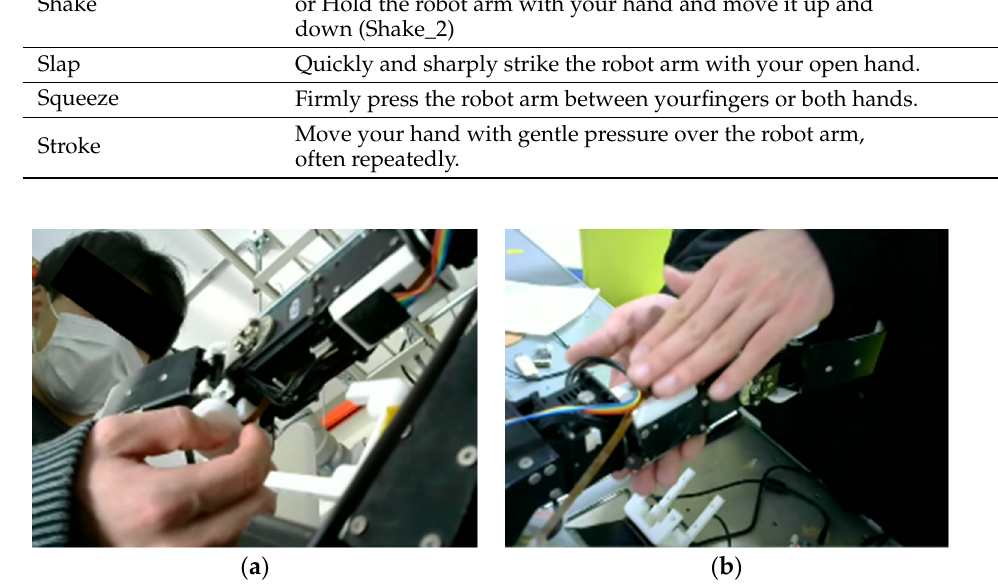
Figure 4. Touch gesture examples on the sensor by one participant. ( a ) Tickle, ( b ) hold double.